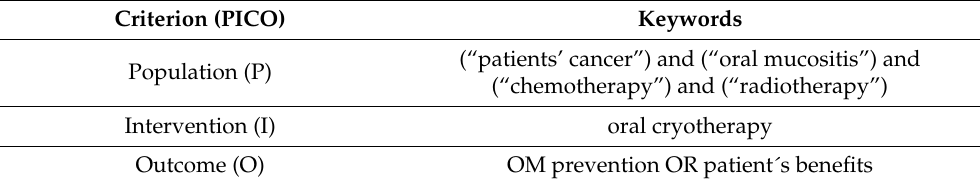
Table 1. PICO criterion. Criterion